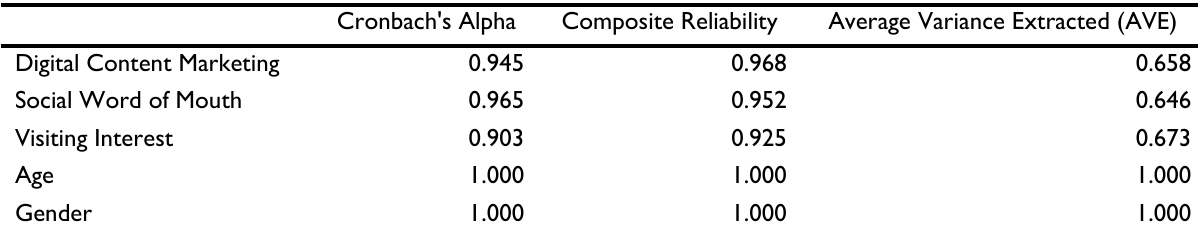
Table 3. Reliability Test